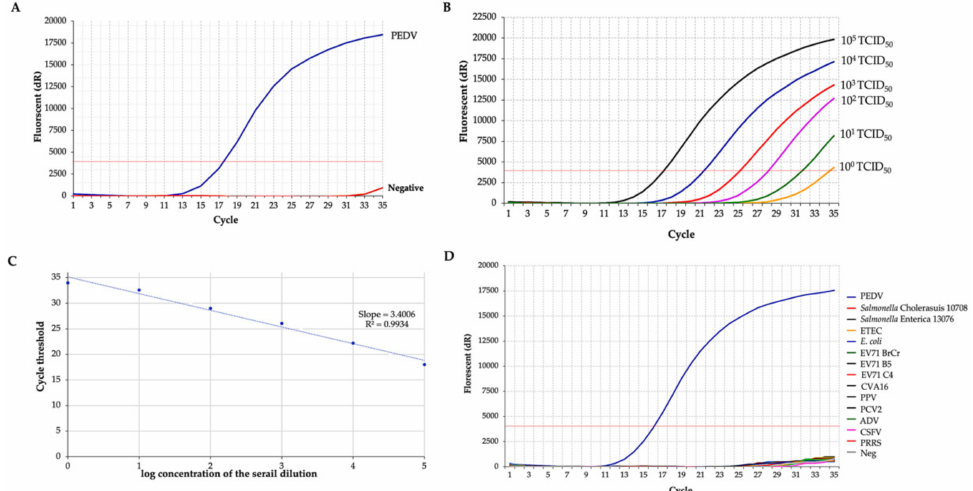
Figure 1. RT-qPCR for PEDV. ( A ) M gene amplification with PEDV. ( B ) PEDV RT-qPCR with other porcine enteric pathogens. ( C ) Sensitivity of PEDV RT-qPCR assay. ( D ) Specificity of PEDV RT-qPCR assay. Negative: the reaction mixture with no